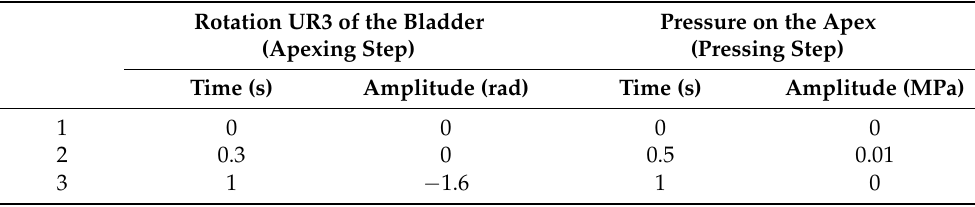
Table 4. Amplitude